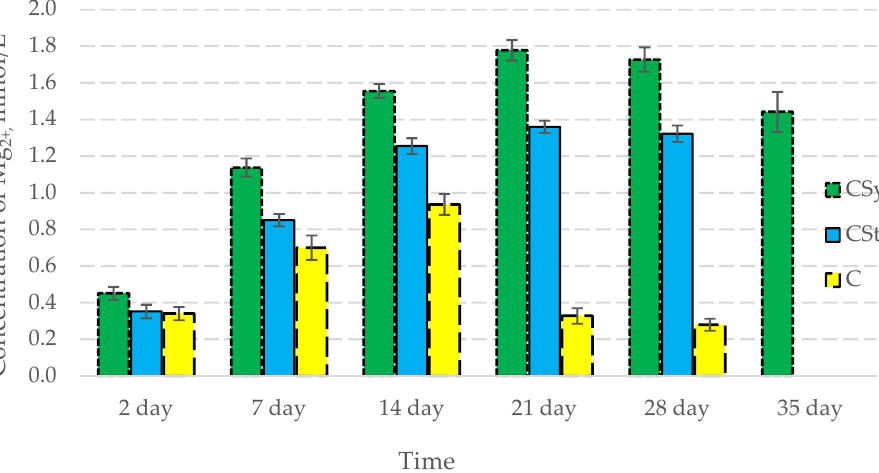
Figure 7. Magnesium concentrations in the 2-, 7-, 14-, 21-, 28-, 35-day-old honey bees’ hemolymph after two methods of supplementation with hemp extract: C—control (pure sugar syrup), Csy—hemp extract in syrup, Cst—hemp extract on strips. (Two-Way ANOVA: supplementation method: F (2,146) = 145,02, p = 0.0000; days of supplementation: F (4,138) = 1312,0, p = 0.0000; supplementation method × days of supplementation F (8,138) = 379,63, p = 0.0000.